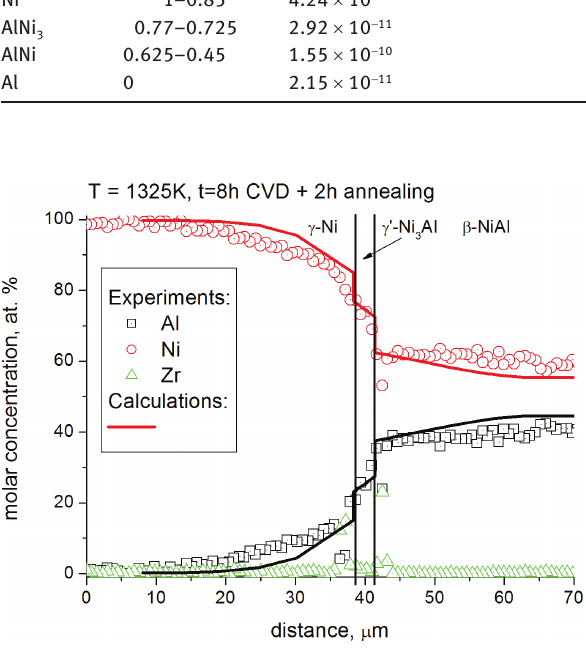
Fig. 7: The comparison of the concentration profile of the NiAl multiphase diffusion experiments (dots) and simulations